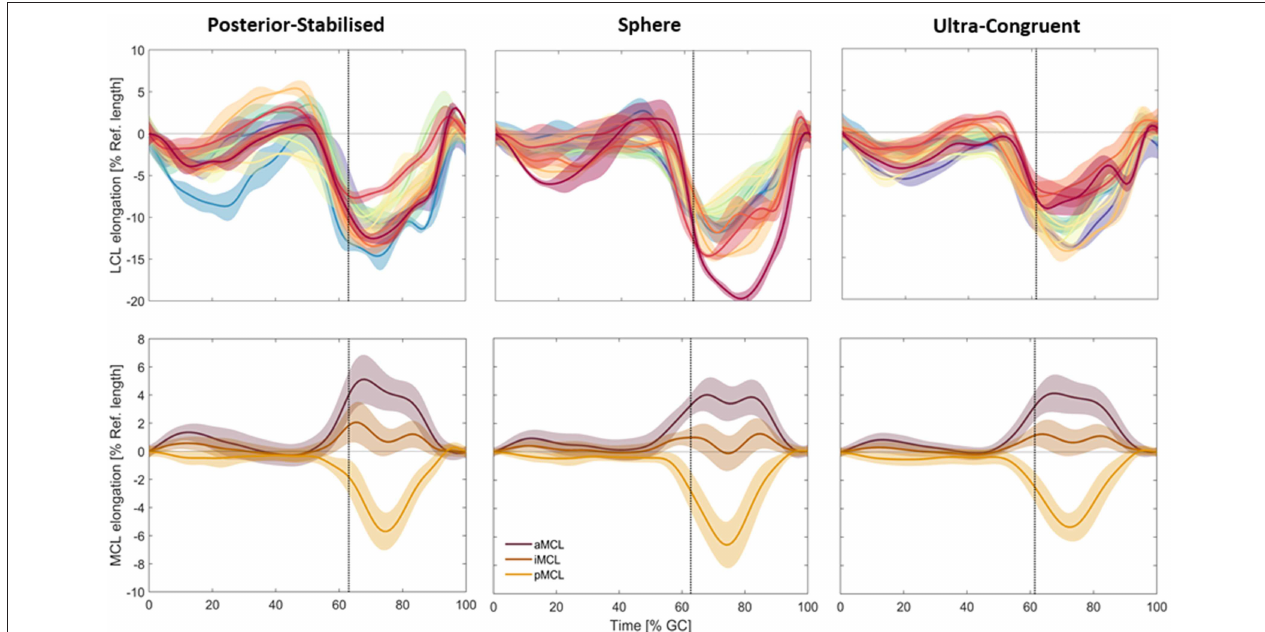
FIGURE 4 | Subject-specific elongation patterns of the LCL ( top , different color each subject, solid lines represent intra-subject means and shadings represent ± SDs) are shown compared to the average elongation patterns of the three MCL bundles ( bottom , solid lines represent inter-subject means and shadings represent ± SDs) during level walking. The vertical dotted line represents the average toe-off time for subjects in the same group.